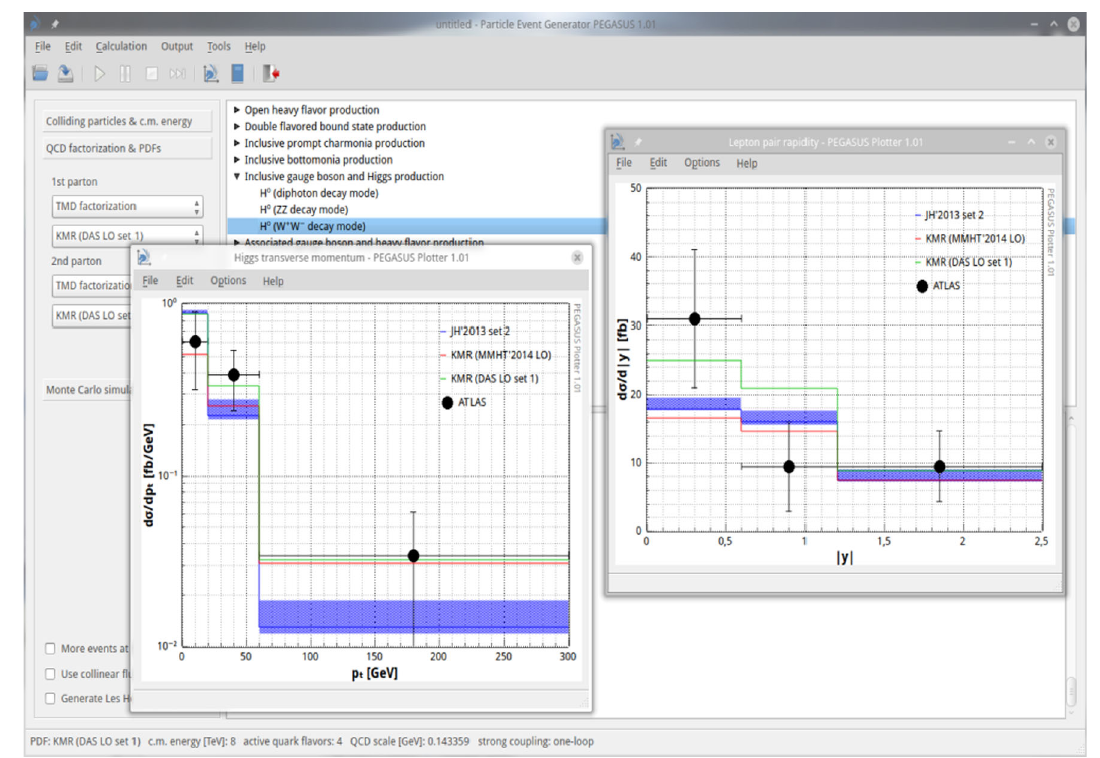
Fig. 7 Results of the calculations presented by pegasus plotter : inclusive Higgs production (in W + W − decay mode) in pp collisions √ s = 8 TeV. The filled areas correspond to the scale uncertainties at